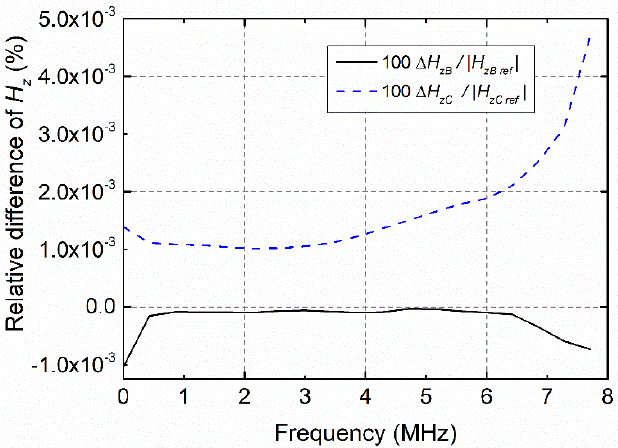
Figure 13. Relative difference in H z between the TLM results proposed in this work and the indepen- dent TLM results used as a reference.